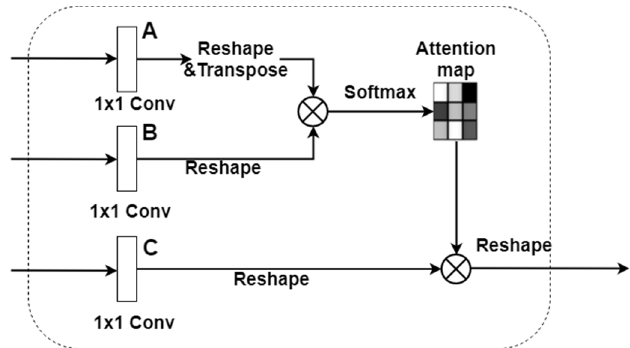
Figure 3. The global module. The number of channels of the CNN feature map is first reduced to 1/8 of the input channels before generating the attention map, and the weighted result is reverted back to the shape of the input feature